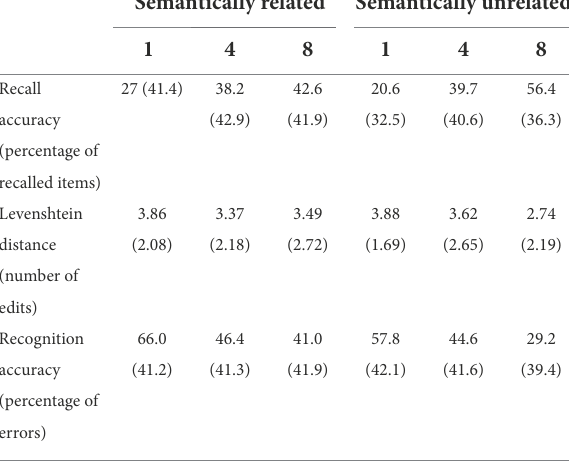
TABLE 2 Means and standard deviations (in parentheses) of the recall and recognition accuracy data (percentage of errors) per condition. Semantically